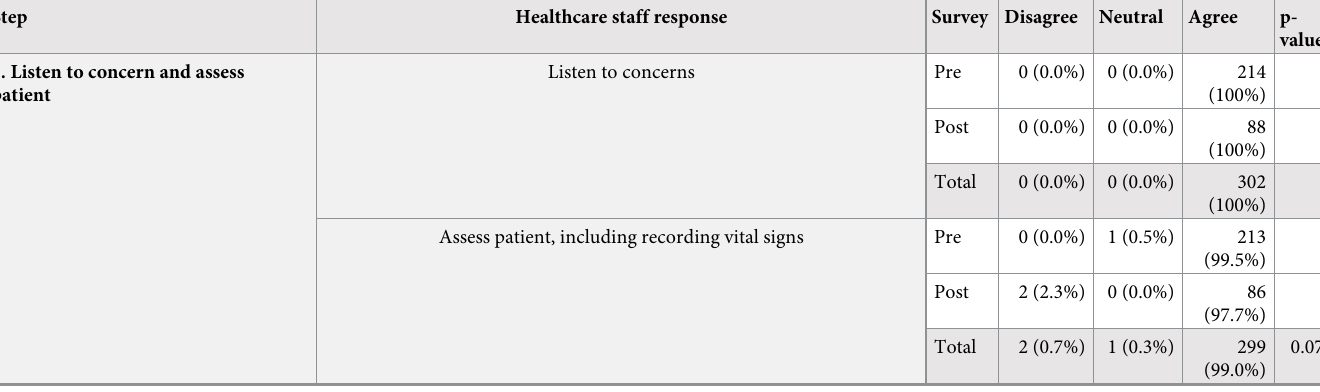
Table 3. Staff perceptions towards responsibilities in response to patient and family concerns of acute clinical